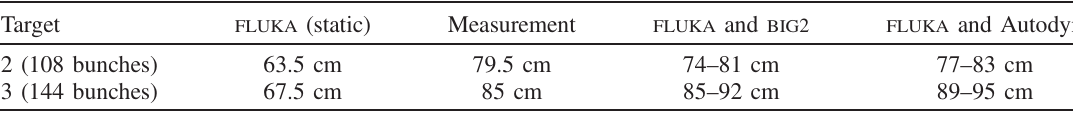
TABLE II. Comparison of the molten depth between simulations and measurements.